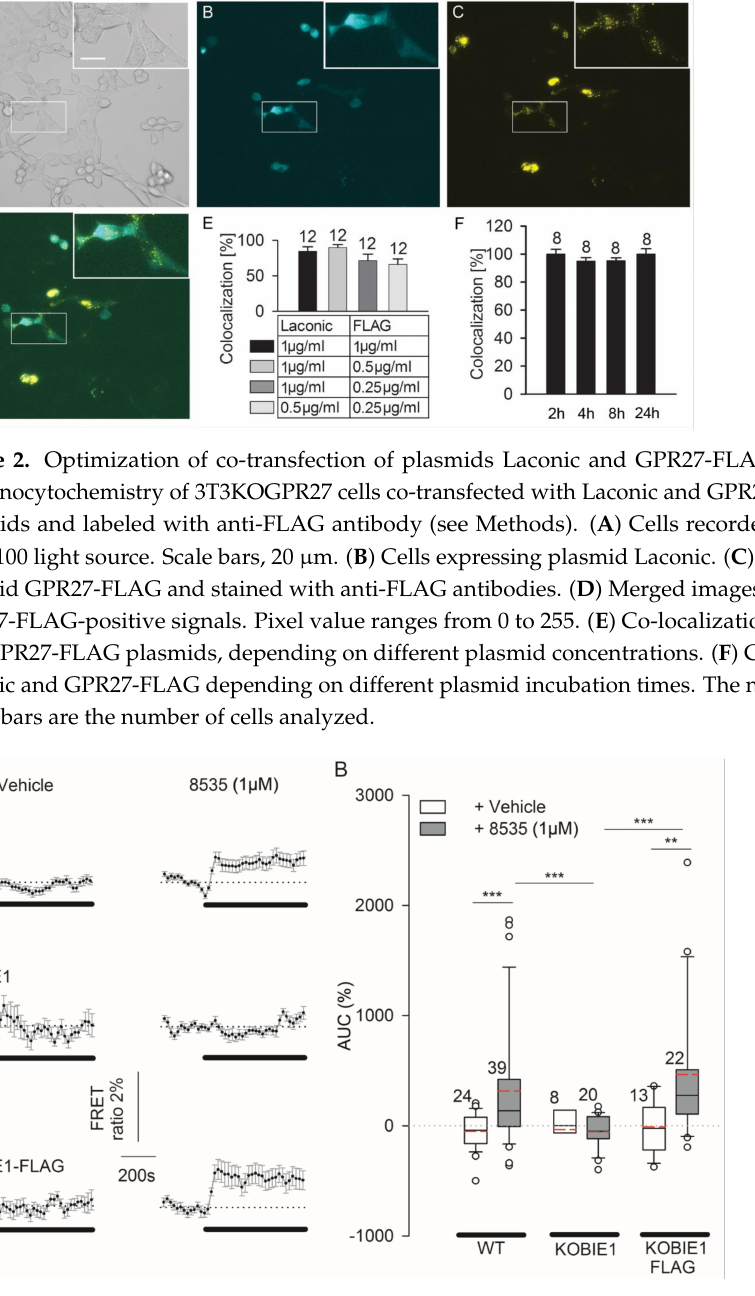
Figure 3. Surrogate GPR27 agonist 8535-induced increase in [lactate] i in GPR27 knockout 3T3 cells is rescued by cell transfection with GPR27 plasmid. ( A ) Mean normalized time course of the Laconic FRET ratio signals reporting [lactate] i , on the addition of extracellular solution (vehicle, left columns) and agonist 8535 (1 µ M, right columns) in 3T3WT cells (WT), in cells with knocked out GPR27 (KOBIE1) and in KOBIE1 cells with overexpressed GPR27 (KOBIE1FLAG). Horizontal black lines indicate the presence of stimuli; the horizontal dotted lines represent the relative baseline value of 1. ( B ) Boxplot comparison of the median area under the curve (AUC) of the Laconic FRET ratio signal, relative to basal levels (in %), on the addition of extracellular solution (vehicle, white) and agonist 8535 (1 µ M; gray) in WT, KOBIE1 and KOBIE1-FLAG cells. Red dashed lines in the boxes represent the average values; white circles are outliers. Two-way and one-way ANOVA on ranks were used. Mann-Whitney rank sum tests were used for the comparison of isolated groups (** p ≤ 0.01, *** p ≤ 0.001). Numbers adjacent to the boxes are the number of cells analyzed from at least three independent cell